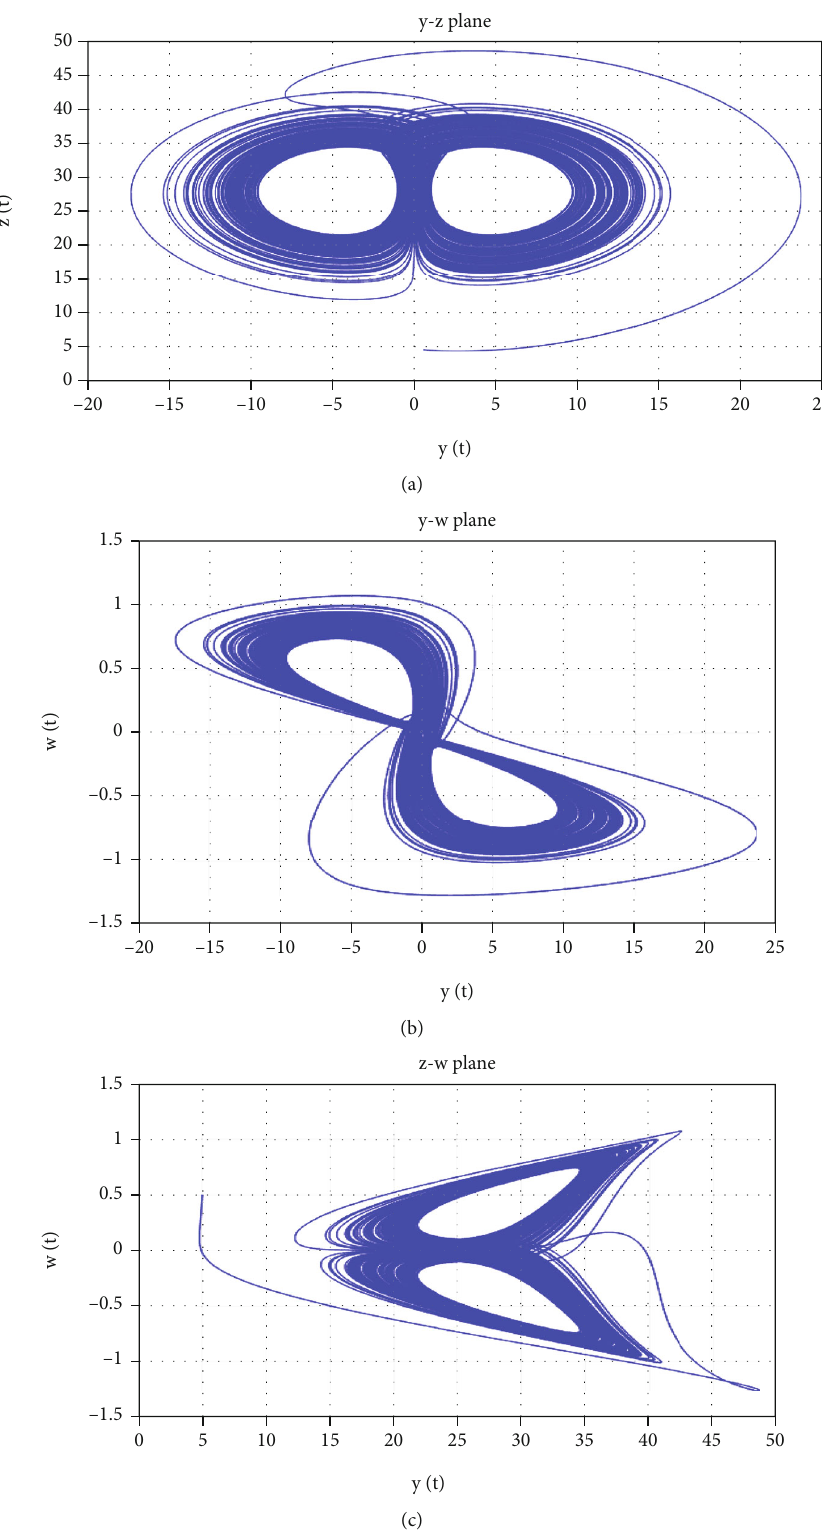
Figure 7: Attractors of the LS system (5) for r = 29 : 6 projected on the planes: (a) z - y , (b) y - w , and (c) z - w